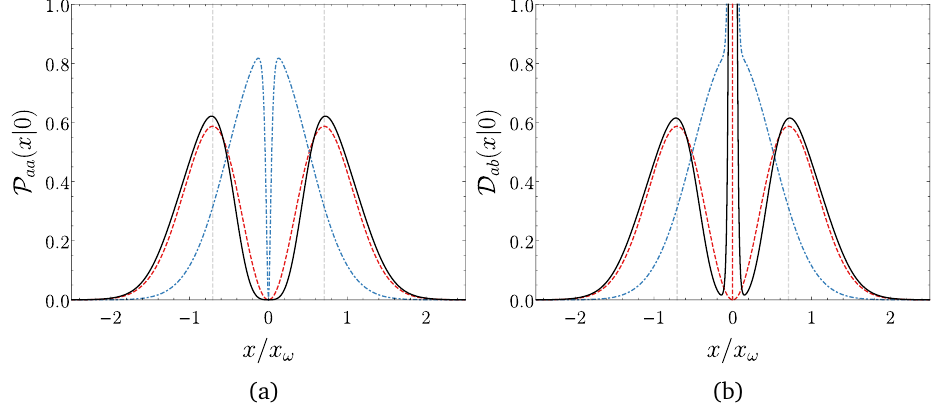
( x | 0 ) to find a fermion of kind a at position Figure 4: a) Conditional probability P aa x when another fermion was already found at the origin. b) Conditional density ( x | 0 ) indicating the density of fermions of kind a at position x conditioned on D ab having found a fermion of kind b at the origin. In both plots the solid black curve is = λ x the numerical result with λ x ω = 30 and n ω . The dashed red curve is the max analytical result for the probability obtained for the point-like hard-core boson limit, and the blue dash-dotted line is the probability predicted by the coboson ansatz in Eq. (12) for N = 2 and λ x ω = 30. Details of the calculations are given in Appendices (cid:112) 2, which are the B and C. The vertical light-gray lines indicate the positions ± x ω / locations of the maxima of the conditional probability for λ → ∞